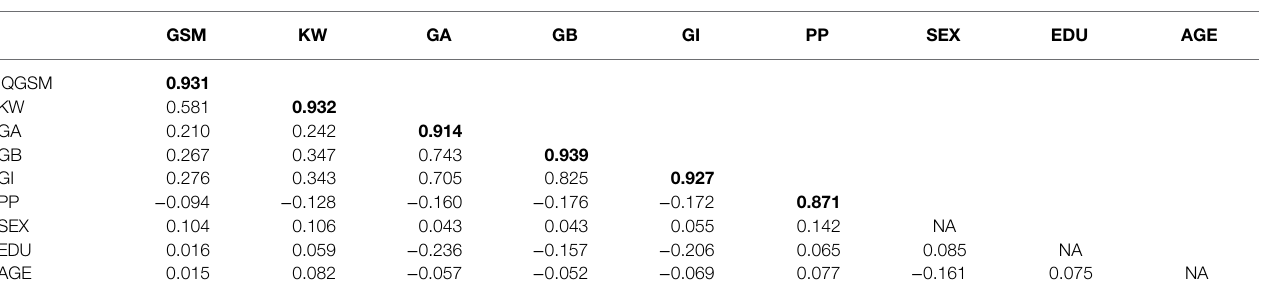
TABLE 2 | Correlation coefficient and square root of